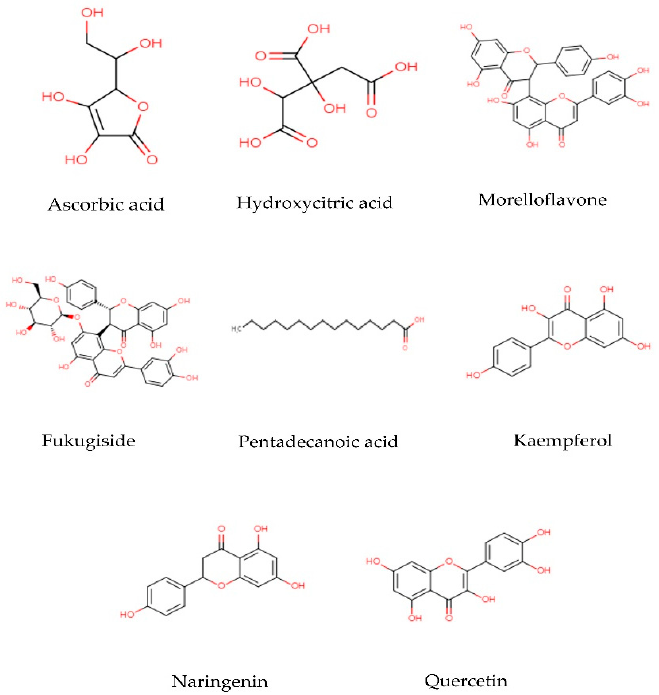
Figure 3. Two dimensional structures of biological active compounds found in the G. atroviridis .